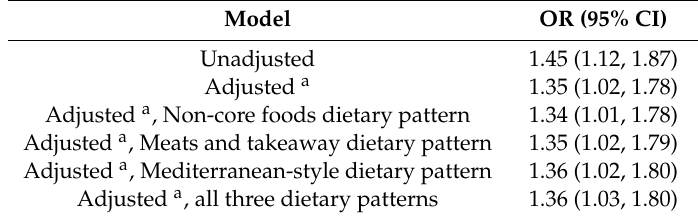
Table 3. Logistic regression examining the association between PCOS and